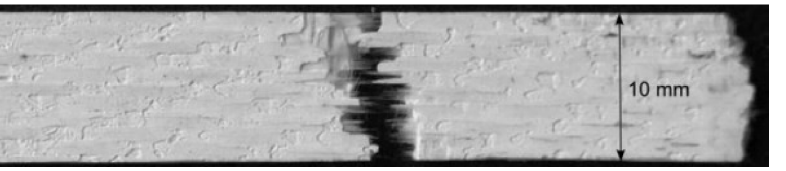
Figure 2. The energy dissipating fibre pullout within an FW12